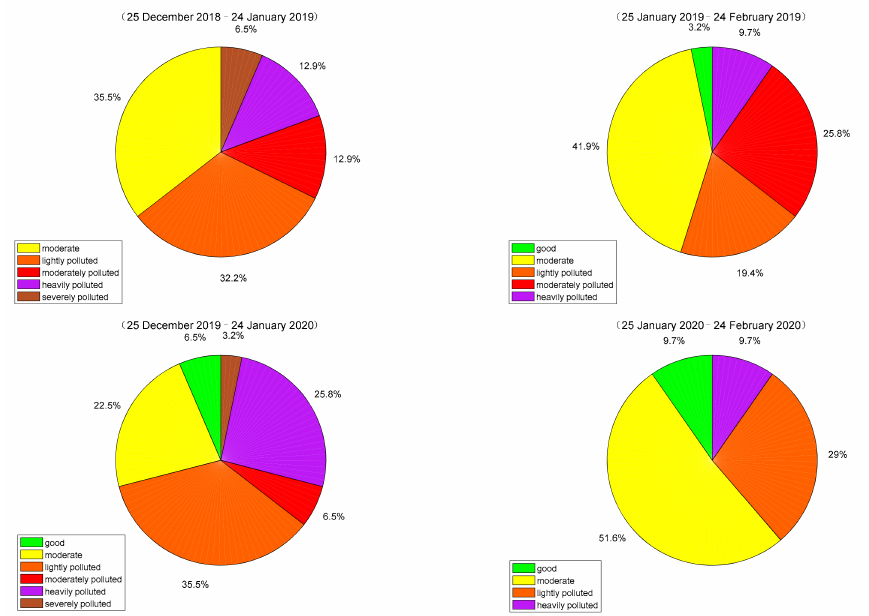
Figure 3. The proportion of days in each band of air quality index (AQI) in different periods. Table 1. The days of each band of AQI in different periods. Lightly Time Good Moderate